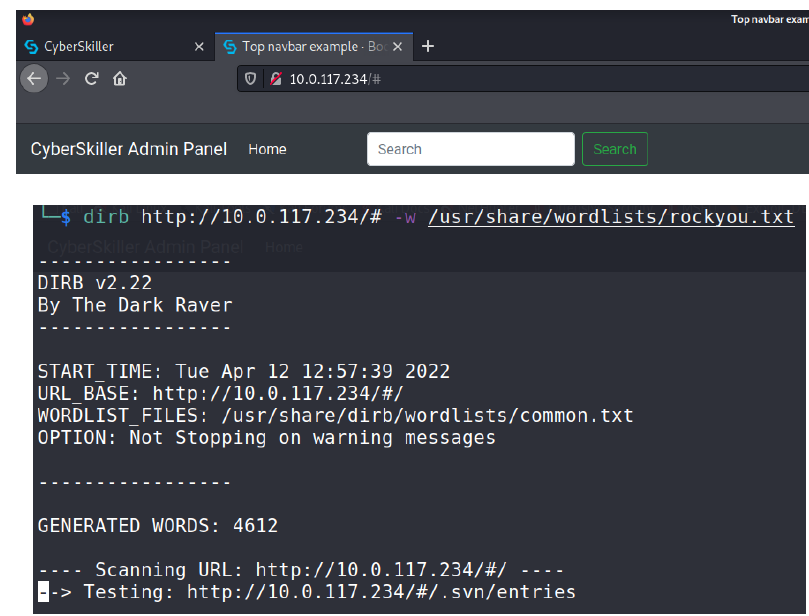
Figure 3. Exercise 3.1: Access to Hidden Pages (⋆⋆)